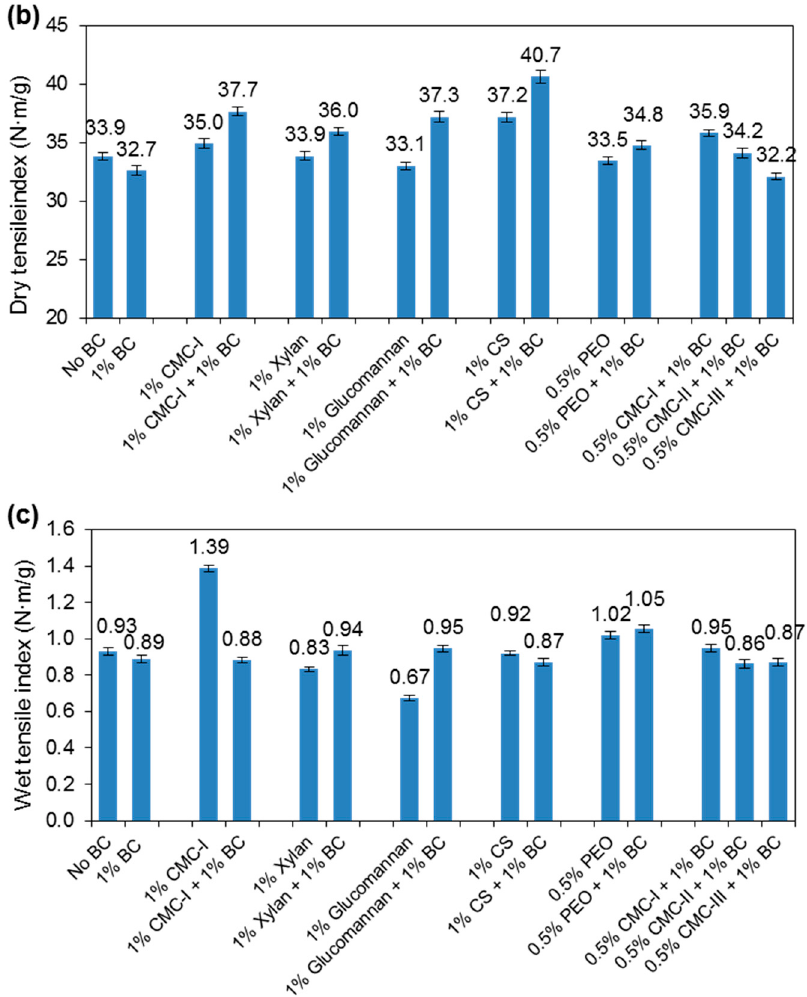
Figure 1. ( a ) Air permeability, ( b ) dry tensile index, and ( c ) wet tensile index of paper hand sheets produced from recycled fibers and different additive macromolecules.